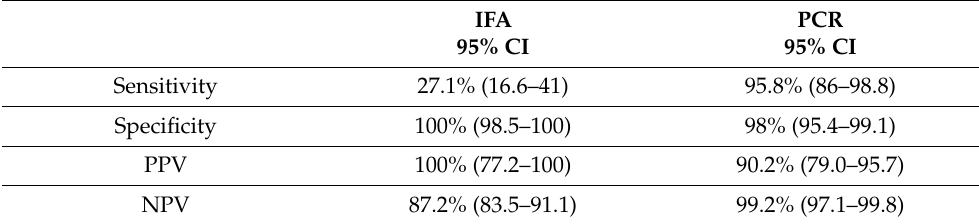
Table 2. Comparison of IFA and PJP PCR